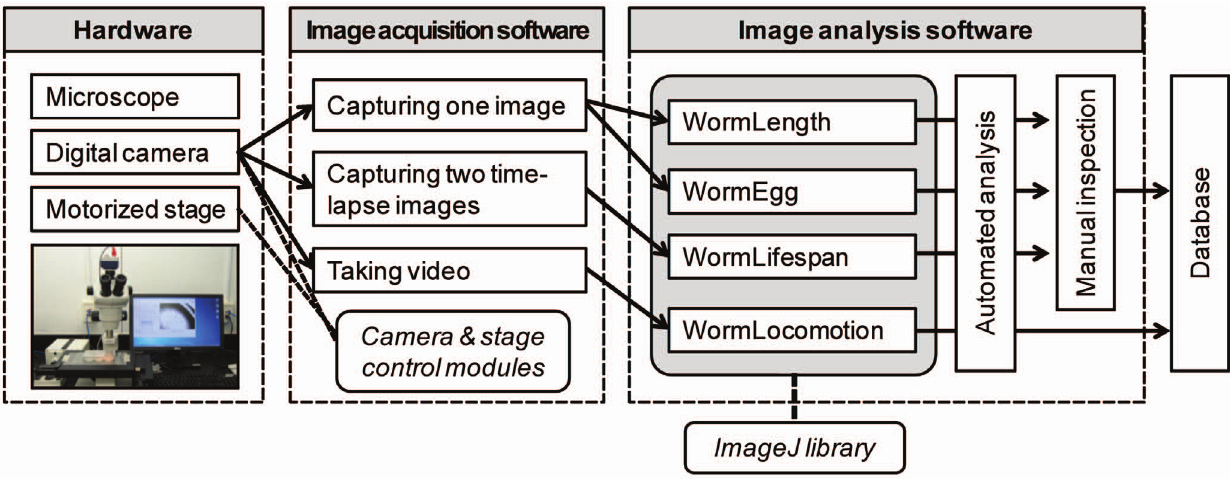
Figure 1. The QuantWorm imaging system. Our imaging system consists of imaging hardware and the QuantWorm software package. The hardware is composed of a microscope equipped with a digital camera and a motorized stage. The image acquisition software is used to control the stage and take images and videos. Four image analysis software programs are used to analyze body size, lifespan, egg laying, and locomotion from the images or videos. Once the software finishes the fully automated image analysis, a user can correct errors in the manual inspection window. Both native image processing algorithms and ImageJ API/library are used to process images.